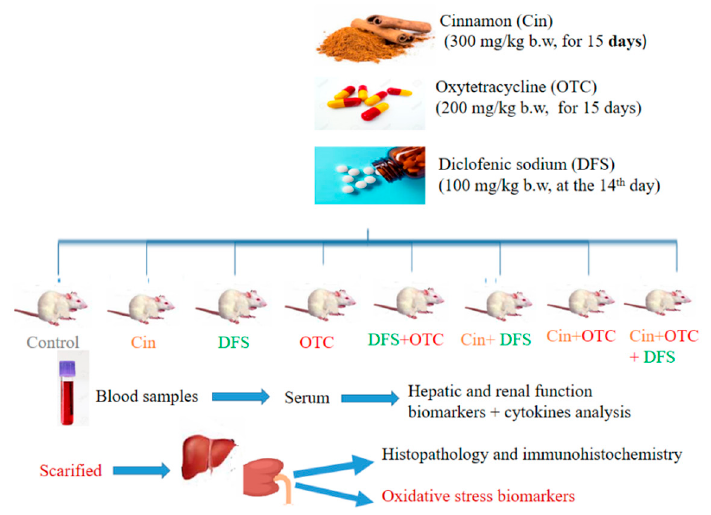
Figure 1. Study diagram and treatment protocol (Cin, Cinnamon; DFS, Diclofenic sodium; OTC,